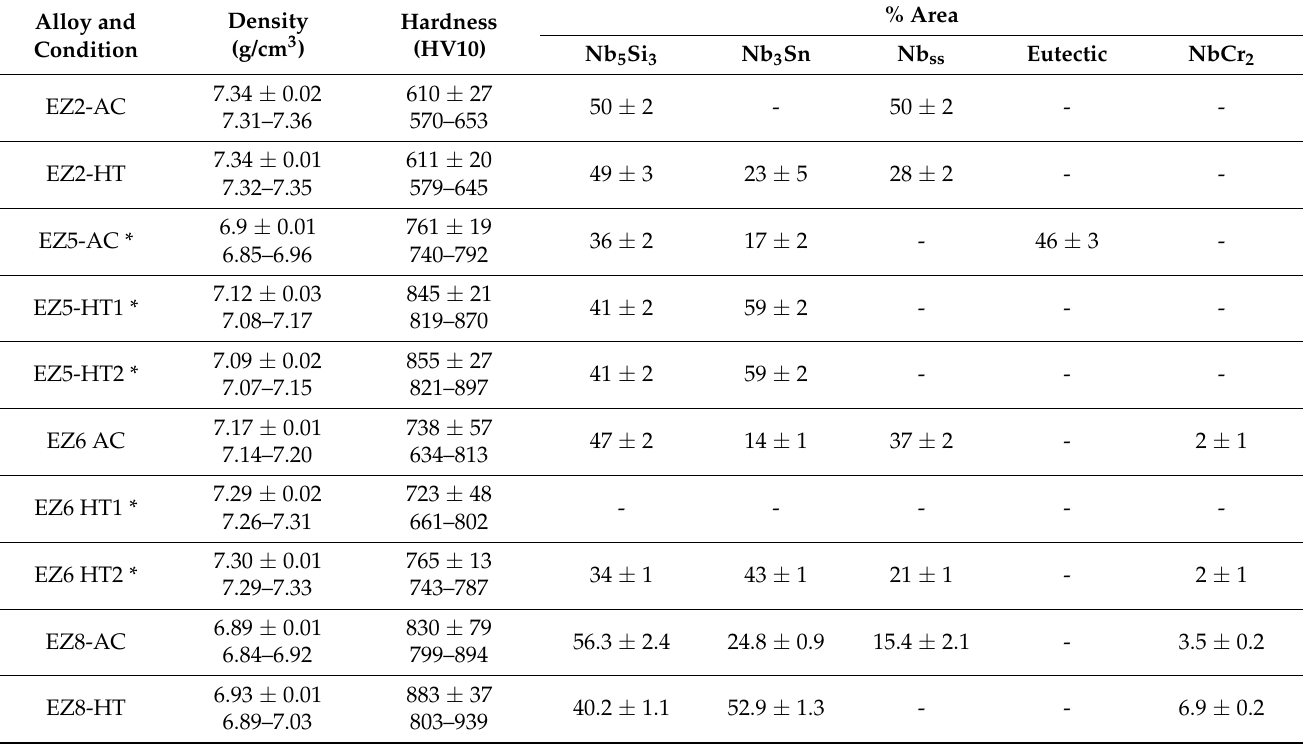
Table 1. Data for the density, hardness, and % area of phases for the alloys EZ2, EZ5, EZ6, and